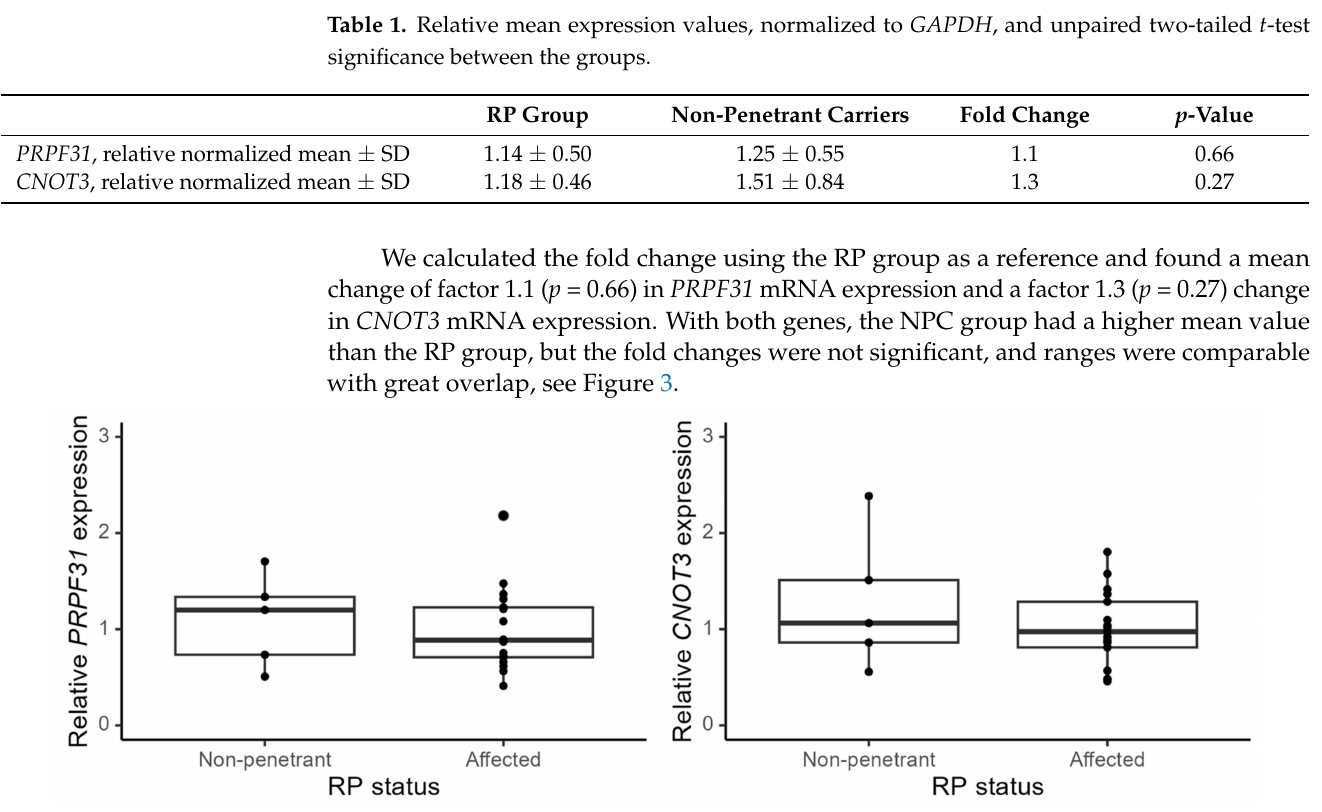
Figure 3. Boxplot of the relative expression in non-penetrant carriers and symptomatic RP individuals (affected). Levels are expressed in fold change with the RP group as reference (mean expression 1.0). PRPF31 ( left ) and CNOT3 ( right ). There is no statistical difference in expression levels between the two groups. The endogenous reference gene used was GAPDH